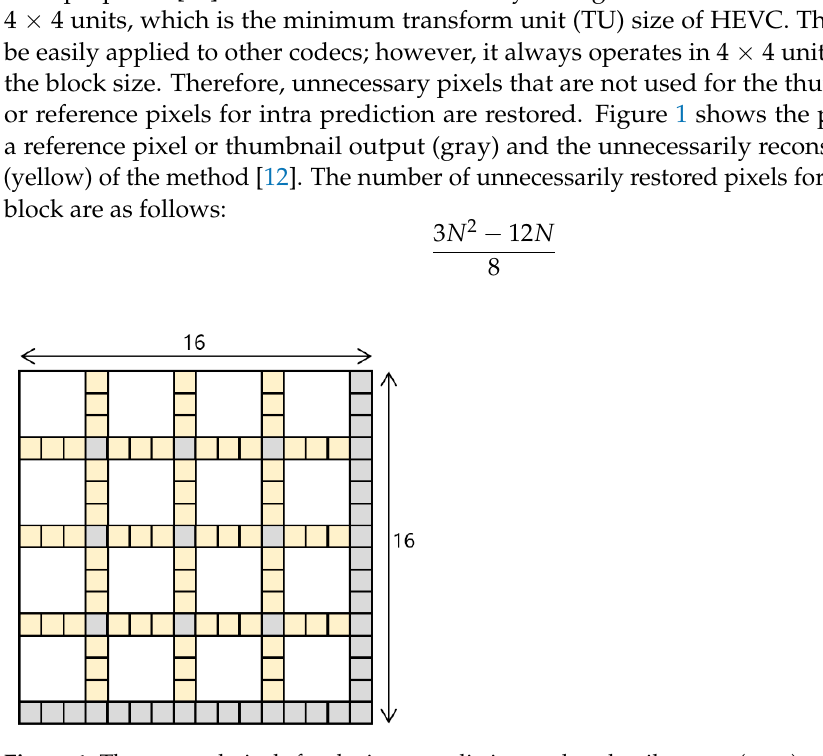
Figure 1. The restored pixels for the intra prediction or thumbnail output (gray) and unnecessarily restored pixels (yellow) in a 16 × 16 block.